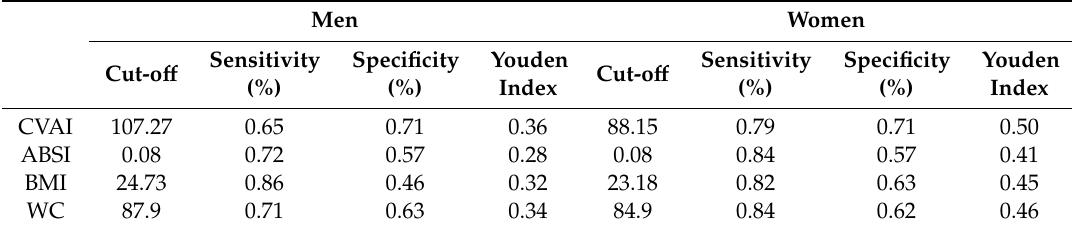
Table 5. Sensitivity, specificity, Youden index and sex-specific cut-o ff points for various obesity indices in predicting diabetes risk among adults in